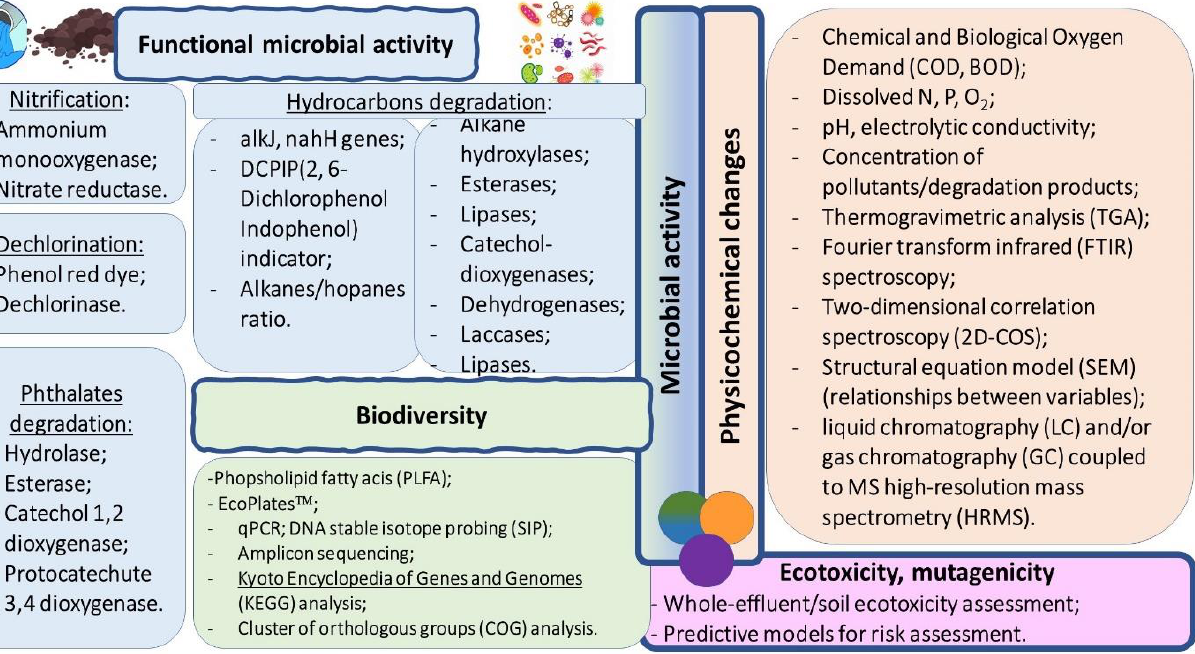
Figure Figure 1. Biomonitoring parameters for assessing the performance of a bioremediation process [16,54,74,77,77,78] .